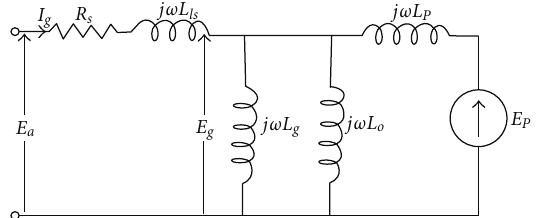
F 2: A equivalent circuit of a hysteresis motor based on an idealized B-H curve of a hysteretic material [1].